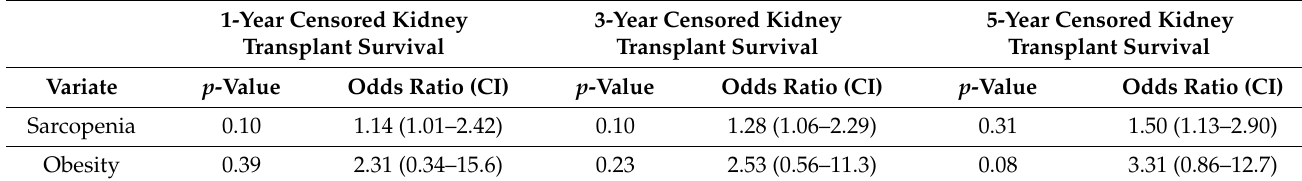
Table 7. Cox regression analysis of 1-year, 3-year and 5-year censored kidney transplant survival with cutoff values for sarcopenia and obesity. CI = confidence interval.